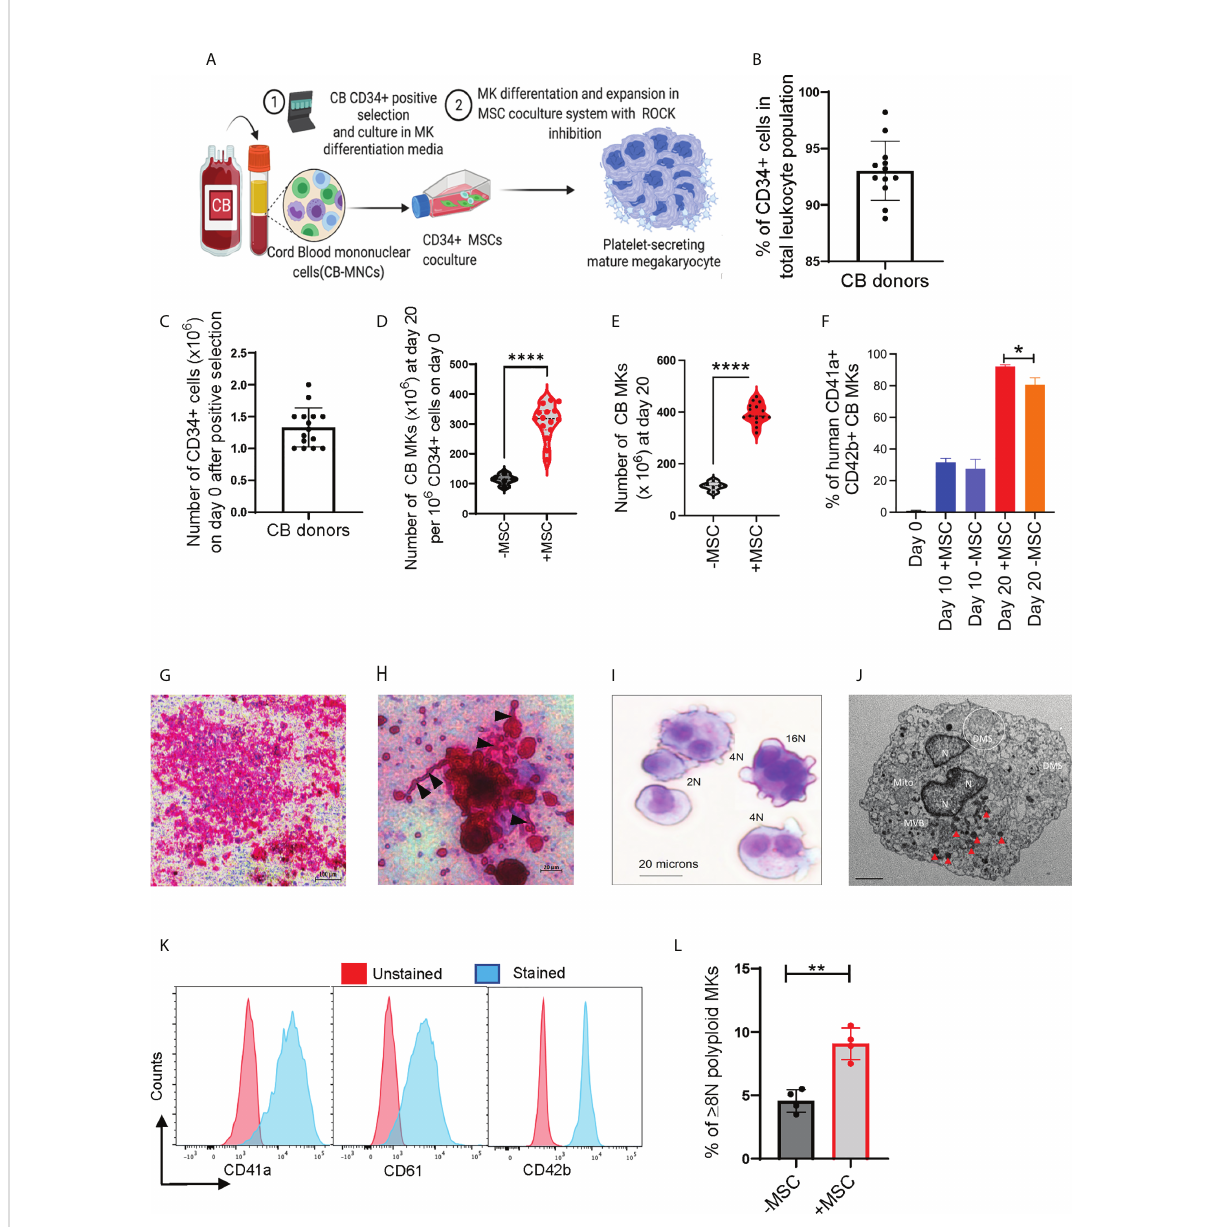
FIGURE 1 MSCs support HSC expansion and MK terminal differentiation from CB CD34+ cells. (A) Schematic of the experimental work fl ow of MK differentiation and platelet production from CB-derived CD34+ cells in an MSC co-culture system. (B) Percentage of CD34+ cells after positive selection amongst multiple cord donors (n=12, each dot represents a different cord). (C) Number of CD34+ cells collected per CB unit after positive selection (n=15, each dot represents a different cord). (D, E) Violin plots comparing fold-change expansion of CD34+ cells (D) and total MKs generated (E) with and without MSC support at day 20 (n=15 in MSC co-culture and n=5 without MSCs, ****p < 0.0001). (F) hCD41+CD42+ expression pattern in CB-MKs cultured with or without MSCs at day 0, 10, and 20 (n=3-4 CB). (G) Human CFU-MK representative image (5X magni fi cation) exhibiting GPIIb/IIIa receptor complex staining in day 12 differentiated CB-MK colonies (scale bar = 100µm). (H) Proplatelet formation (black triangles) and released platelets in the day 12 CFU-MK image (scale bar = 20µm). (I) Giemsa staining of a day 23 expanded mature CB-MK showing polyploid nuclei. (J) Representative transmission electron microscopy (TEM) 5000X magni fi cation image of a CB-MK (Abbreviations: DMS, demarcation membrane system; Mito, mitochondria; MVB, multivesicular bodies; N, nucleus; red arrows, granules; scale bar = 2µm). (K) Representative histograms depicting the expression of hCD41a, hCD42b and hCD61 expression (blue) in day 22 MKs compared to unstained controls (red). (L) Ploidy of CB-MKs generated in the presence or absence of MSCs and 10µM Y27632, quanti fi ed by propidium iodide staining (n=4 with MSCs and 4 without MSCs, **p < 0.01). All statistical analyses completed with unpaired t-tests. * means